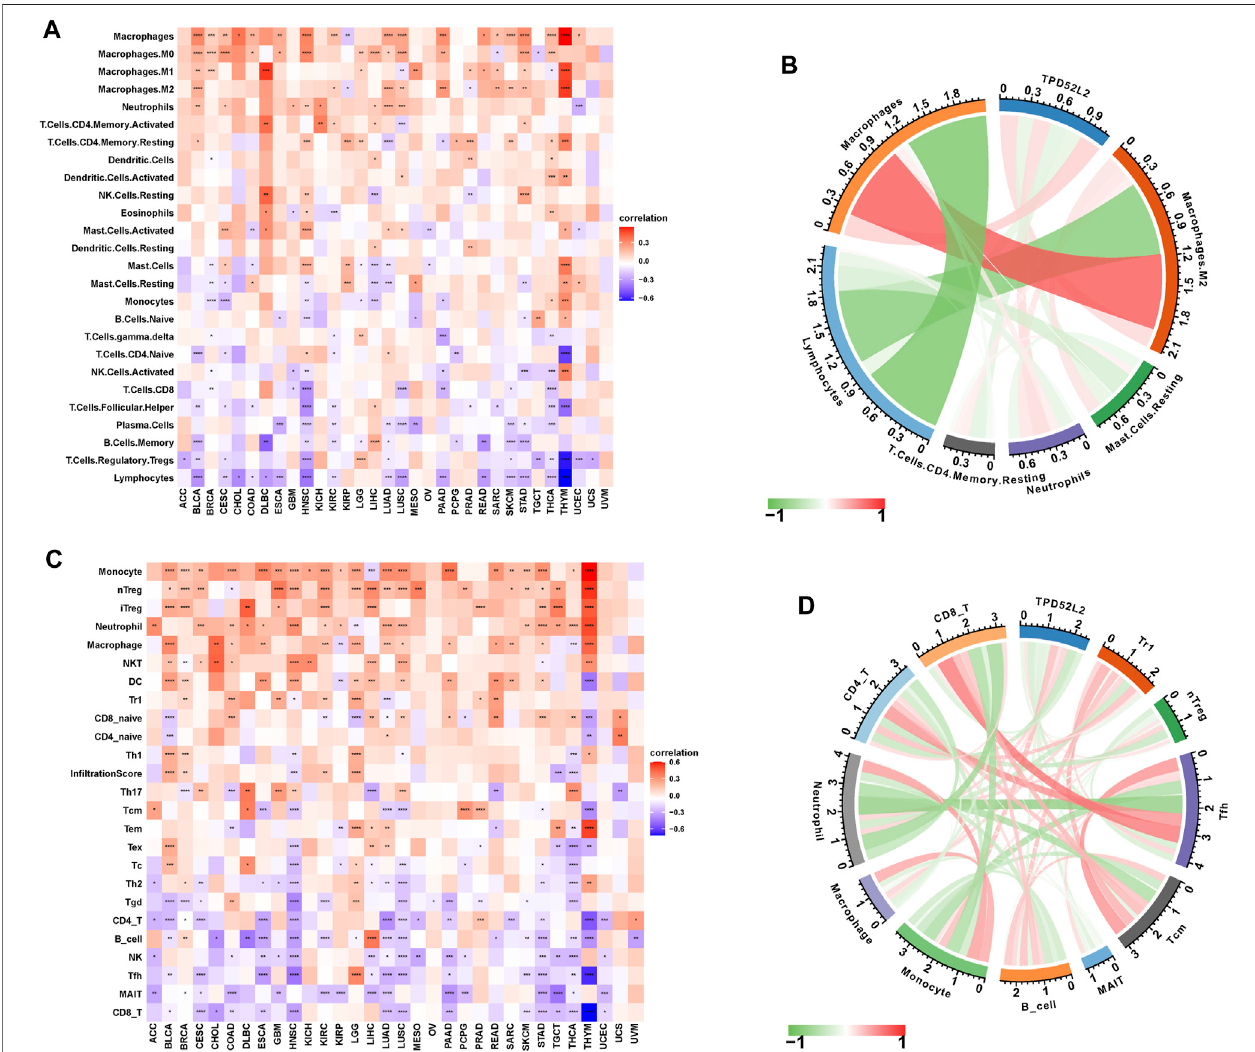
FIGURE7| Immune in fi ltration analysis. (A) CorrelationbetweenTPD52L2 expression and in fi ltration levels of26immune cellsdownloadedfrom apublished work in pan-cancer. Red represents positive correlation, blue represents negative correlation, and the darker the color, the stronger the correlation. (B) Correlation between TPD52L2 expression and indicated immunecells downloaded from a published work in LUAD. (C) Correlation between TPD52L2 expression and in fi ltration levels of24 immune cells from ImmuCellAI in pan-cancer. (D) Correlation between TPD52L2 expression and indicated immune cells in the ImmuCellAI cohort in LUAD.